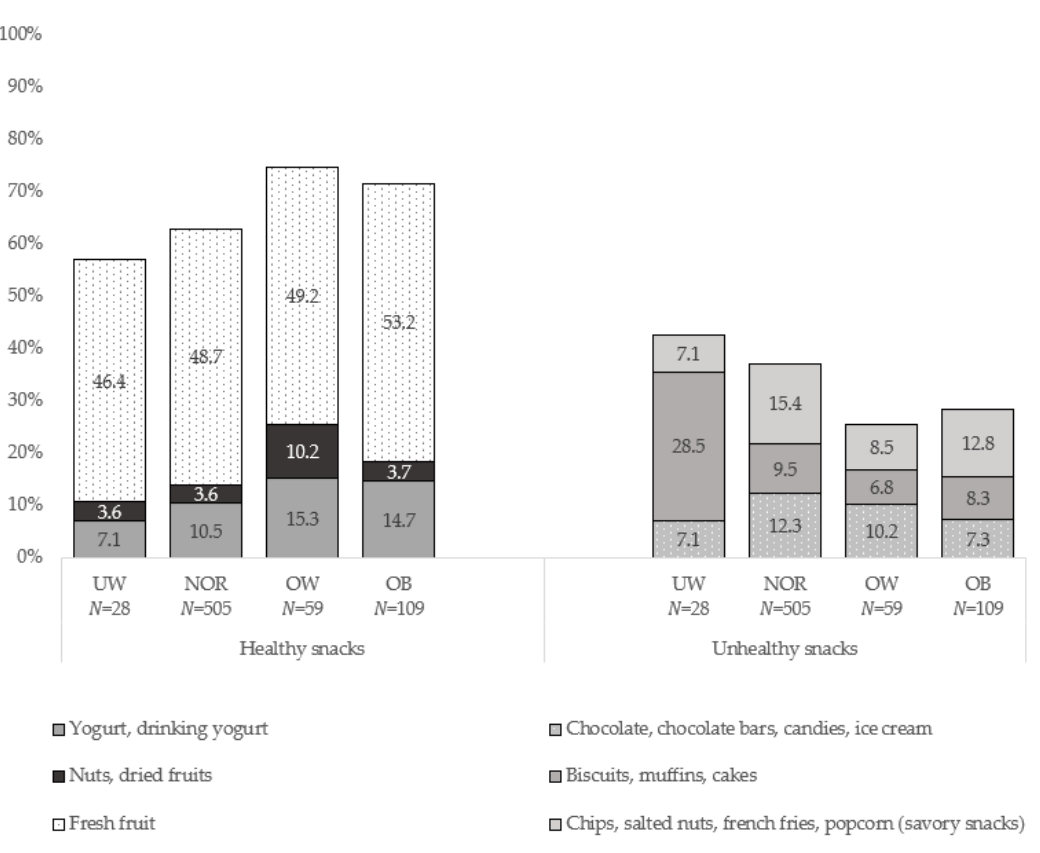
Figure 1. Proportion of snack intake in various weight groups. UW—underweight; NOR—normal weight; OW—overweight;